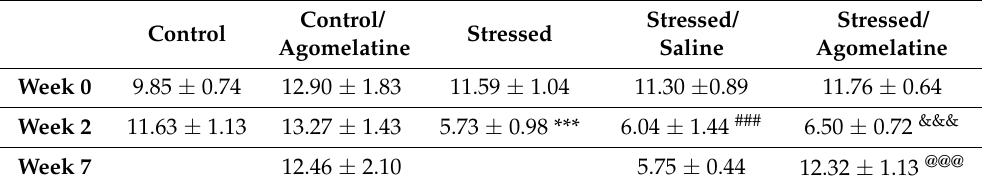
Table 1. Sucrose intakes in animals exposed to chronic mild stress (CMS) for 2 weeks and in animals exposed to CMS for 7 weeks and administered vehicle (1 mL/kg) or agomelatine (10 mg/kg) for 5 weeks. Control